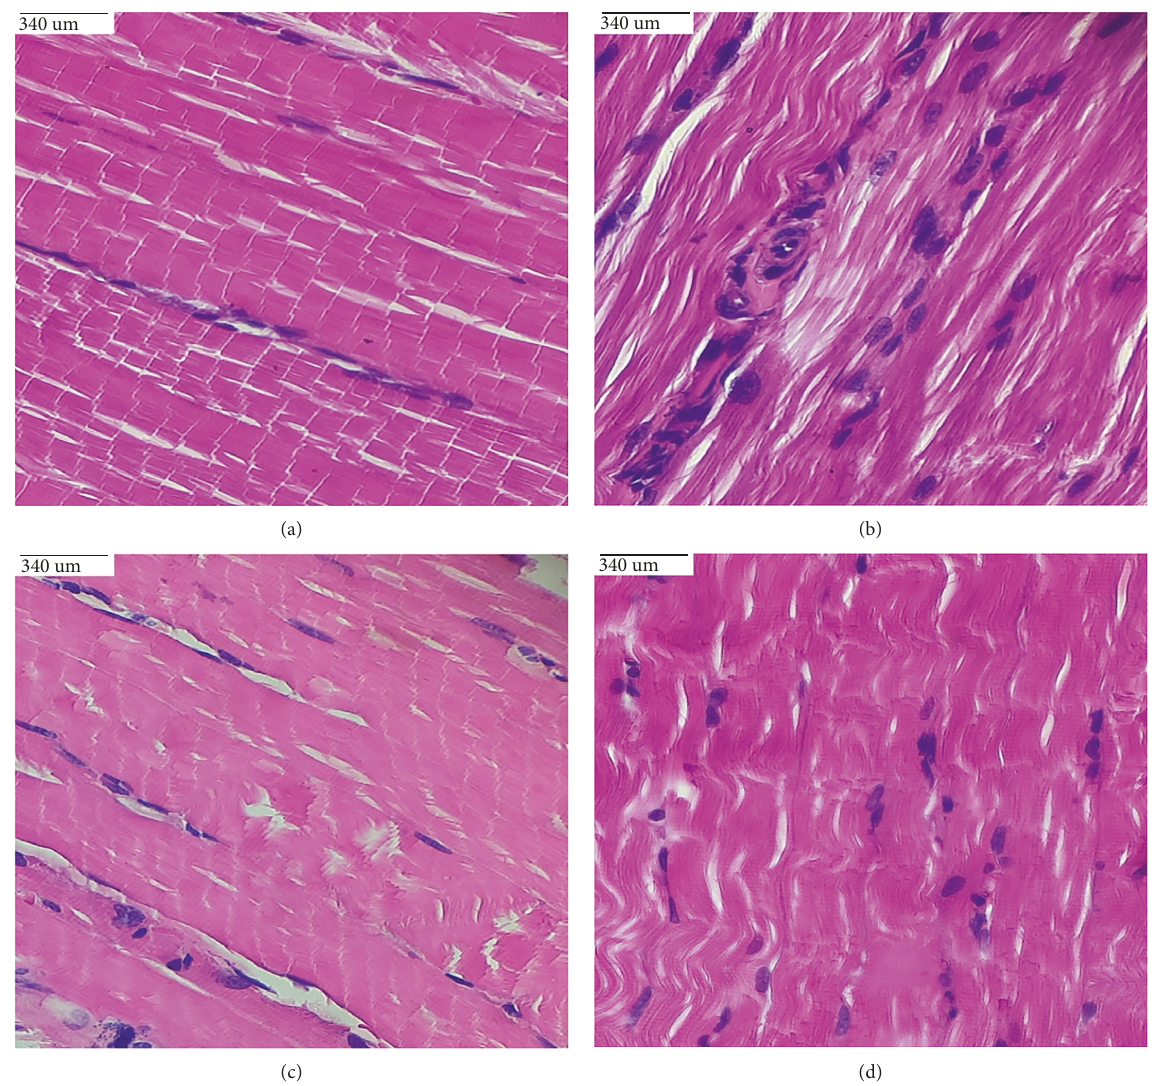
Figure 11: (a–d). Histological sections of the gastrocnemius muscle in (a) control rats reveal normal parallel acidophilic myofibers grouped in bundles; (b) diet-induced diabetic rats show crumbling myofibers with many peripheral flattened nuclei; (c) widespread myofibers with peripheral nuclei in diet-fed diabetic rats treated with β -sitosterol; (d) aligned myofibers with few crushed marginal nuclei in diet-induced diabetic rats treated with